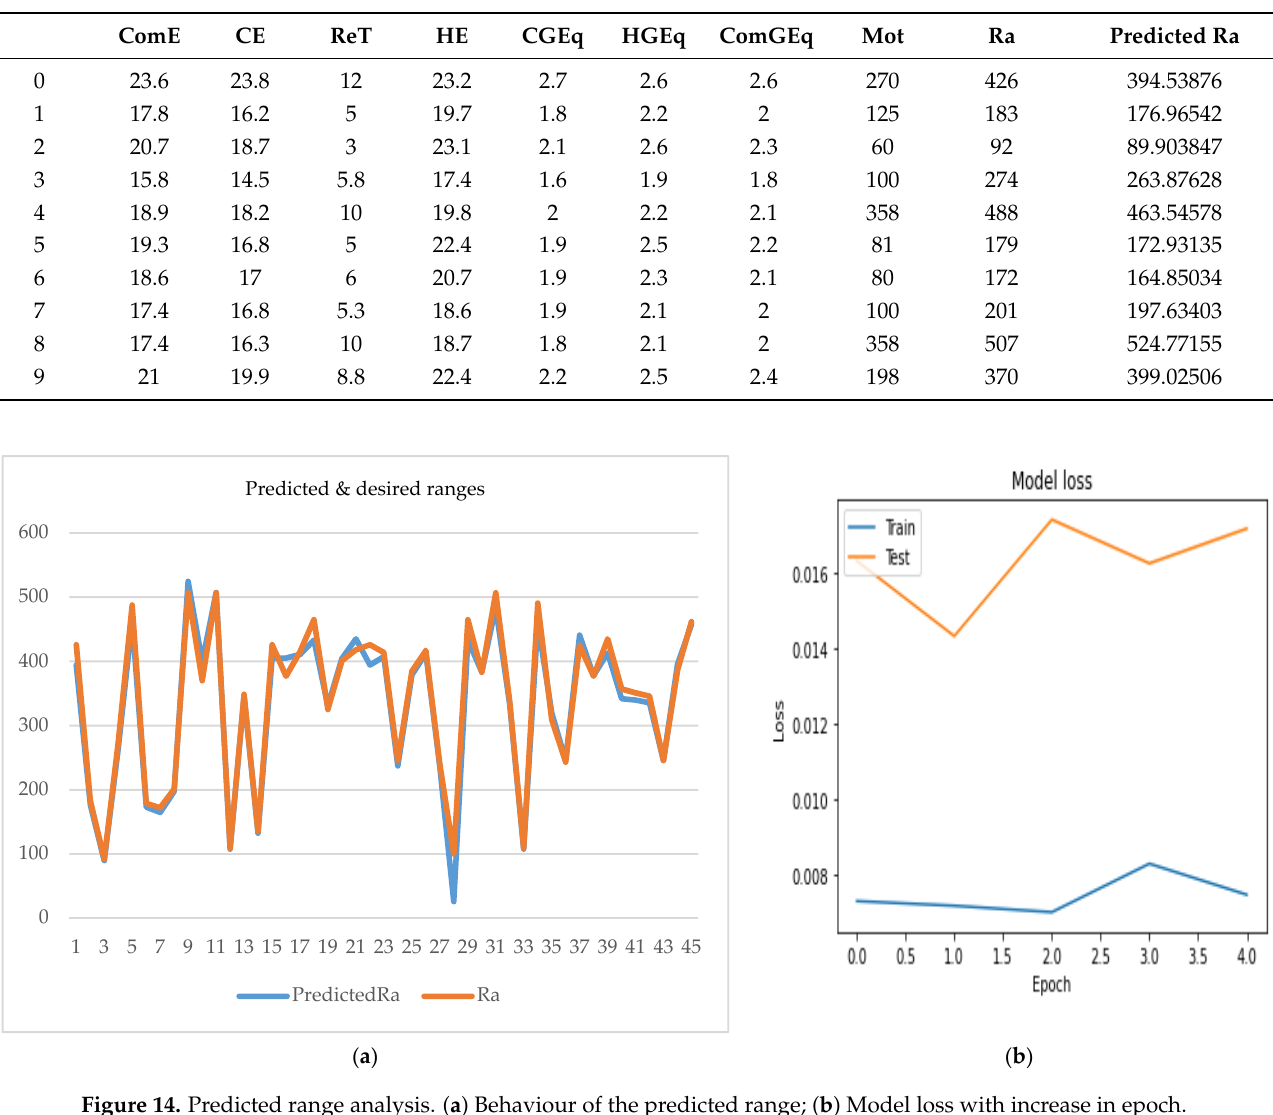
Table 10. Predicted and desired ranges.